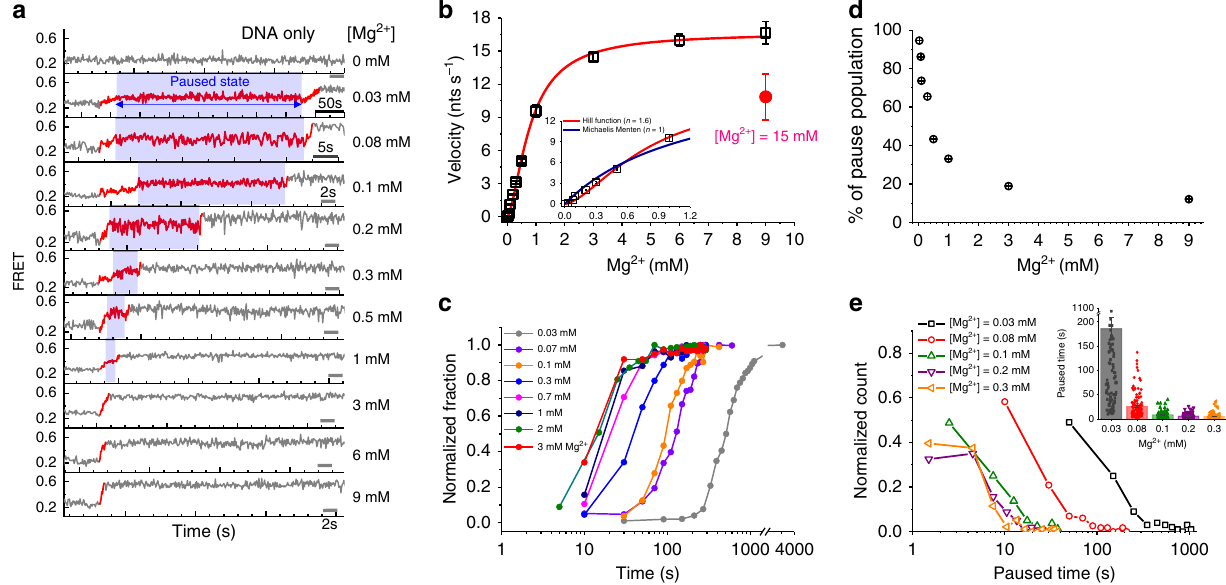
Fig. 2 Mg 2 + -dependent degradation of DNA by λ -exonuclease. a Representative traces showing that degradation reaction slows down at lower Mg 2 + concentrations (0 mM, 0.03 mM, 0.08 mM, 0.1 mM, 0.2 mM, 0.3 mM, 0.5 mM, 1 mM, 3 mM, 6 mM, and 9 mM Mg 2 + : top to bottom) at the fi xed 16 nM λ - exonuclease (trimer concentration unless otherwise stated). b The degradation rate (velocity) versus Mg 2 + concentrations following a Hill fi t (red line) with a maximum velocity of 17.2 nt s − 1 , a Km value of 0.885 mM of Mg 2 + , and n = 1.6. Inset, blowing up at lower Mg 2 + concentrations showing fi tting to a sigmoidal kinetics (red) versus a Michaelis Menten kinetics (blue). Error bars denote the standard error of the mean (SEM). The velocity at [Mg 2 + ] = 15 mM is highlighted in red. c Time-dependent fractional growth at various Mg 2 + concentrations. d The proportion of the pause population as a function of the Mg 2 + concentration. e Distribution of pause times with varying concentrations of Mg 2 +